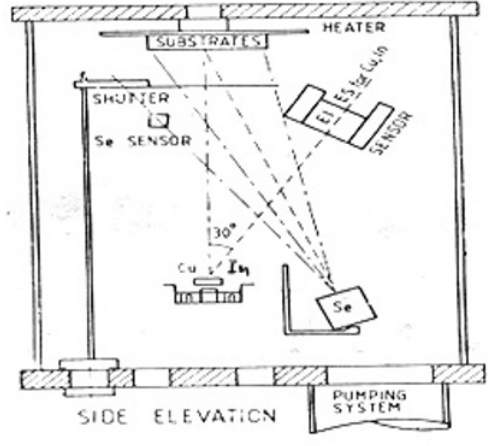
Figure 1. Arrangement for CuInSe 2 film deposition by Co- evaporation technique